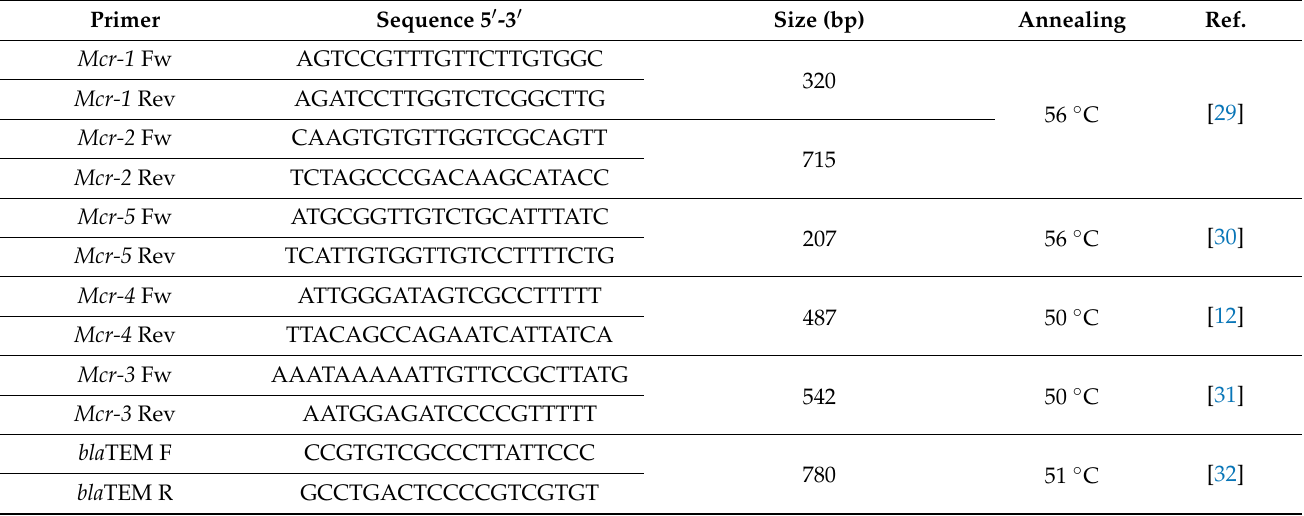
Table 2. Details of oligonucleotides used for the detection of antimicrobial resistance and virulence factors